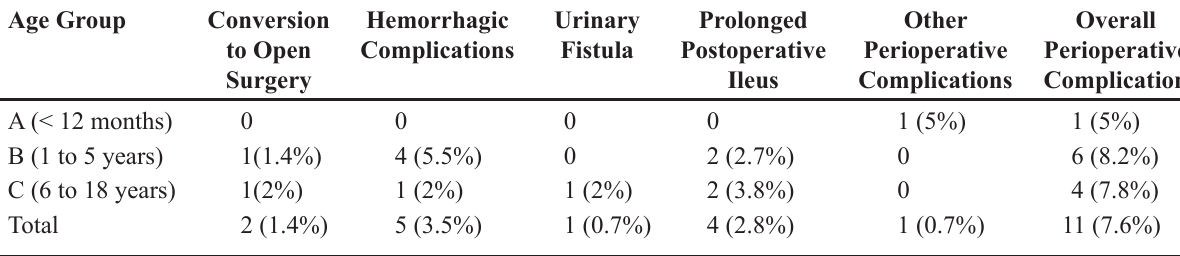
Table 3 – Frequency of perioperative complications in each age